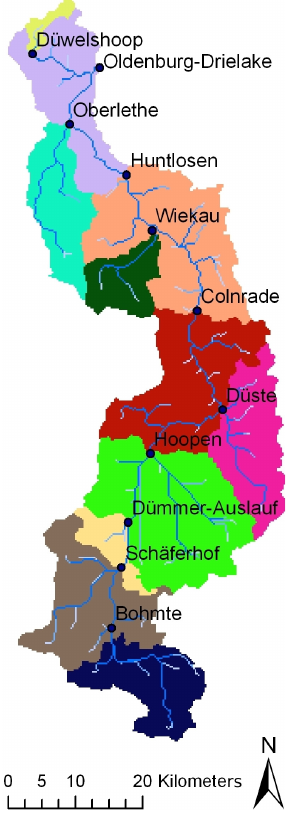
Fig. 1. Catchment of the Hunte river, showing 10subcatchments with available gauge data used for the model